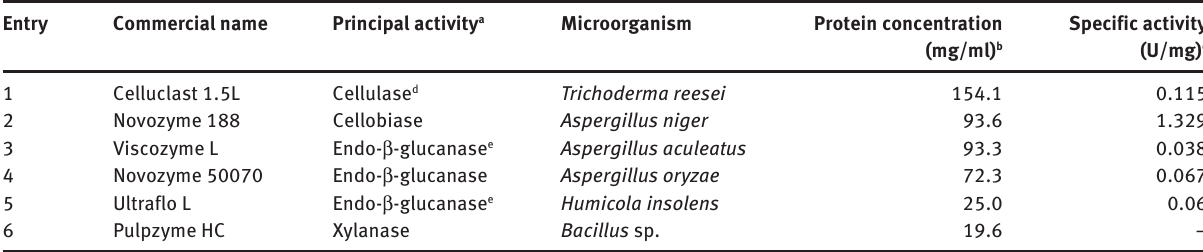
Table 1 Enzymes and enzymatic complexes used in this